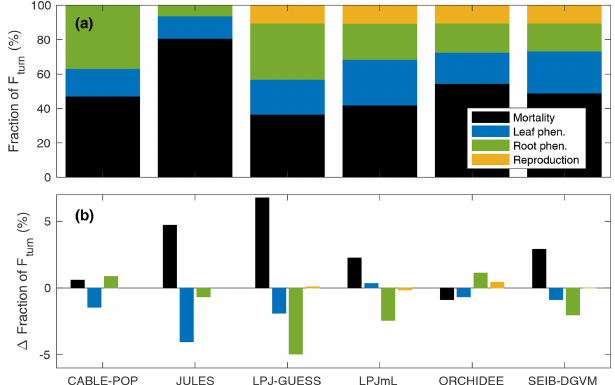
Figure 3. Fraction of global F turn resulting from individual model processes. (a) For 1985–2014 in the CRU-NCEP-forced simulation. (b) Change in fraction of F turn (percentage points) between 1985– 2014 and 2070–2099 in the simulations forced by IPSL-CM5A-LR RCP8.5 bias-corrected climate data. Black is mortality; light blue is leaf phenological turnover; green is root phenological turnover; and yellow is reproductive turnover.